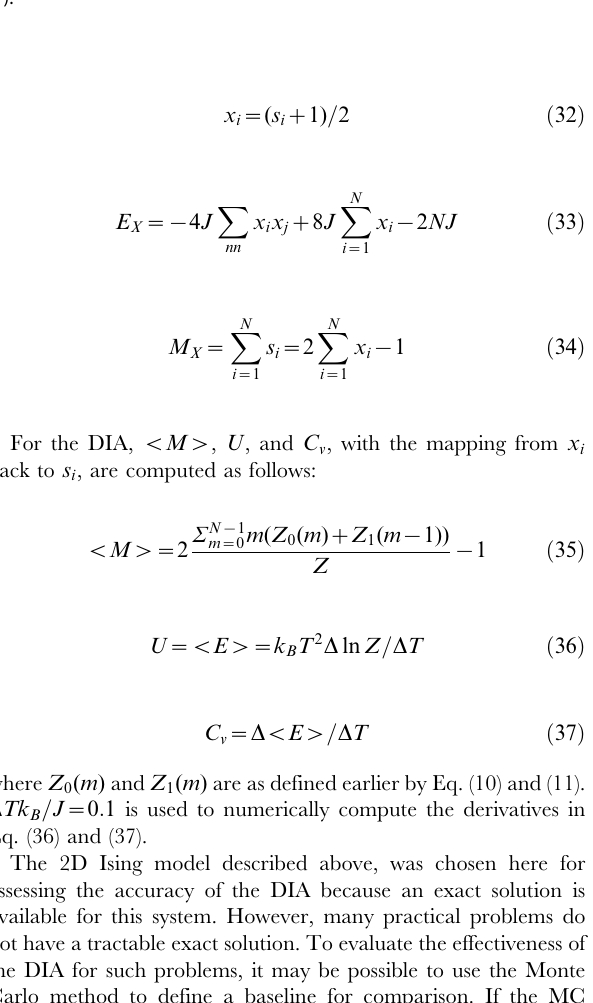
Figure 3. Split-merge algorithm. Consider an 8-particle system, with particle 1 being the selected particle. First, the split-merge algorithm recursively separates the particles, other than the selected particle, into a hierarchical binary tree. Next, the elementary symmetric function (ESF) for the leaf nodes, which consist of a single particle, are calculated. The ESF for all the other nodes, are then computed by recursively, starting from the bottom, merging the ESF from the two branches for each node using Eq. (21).